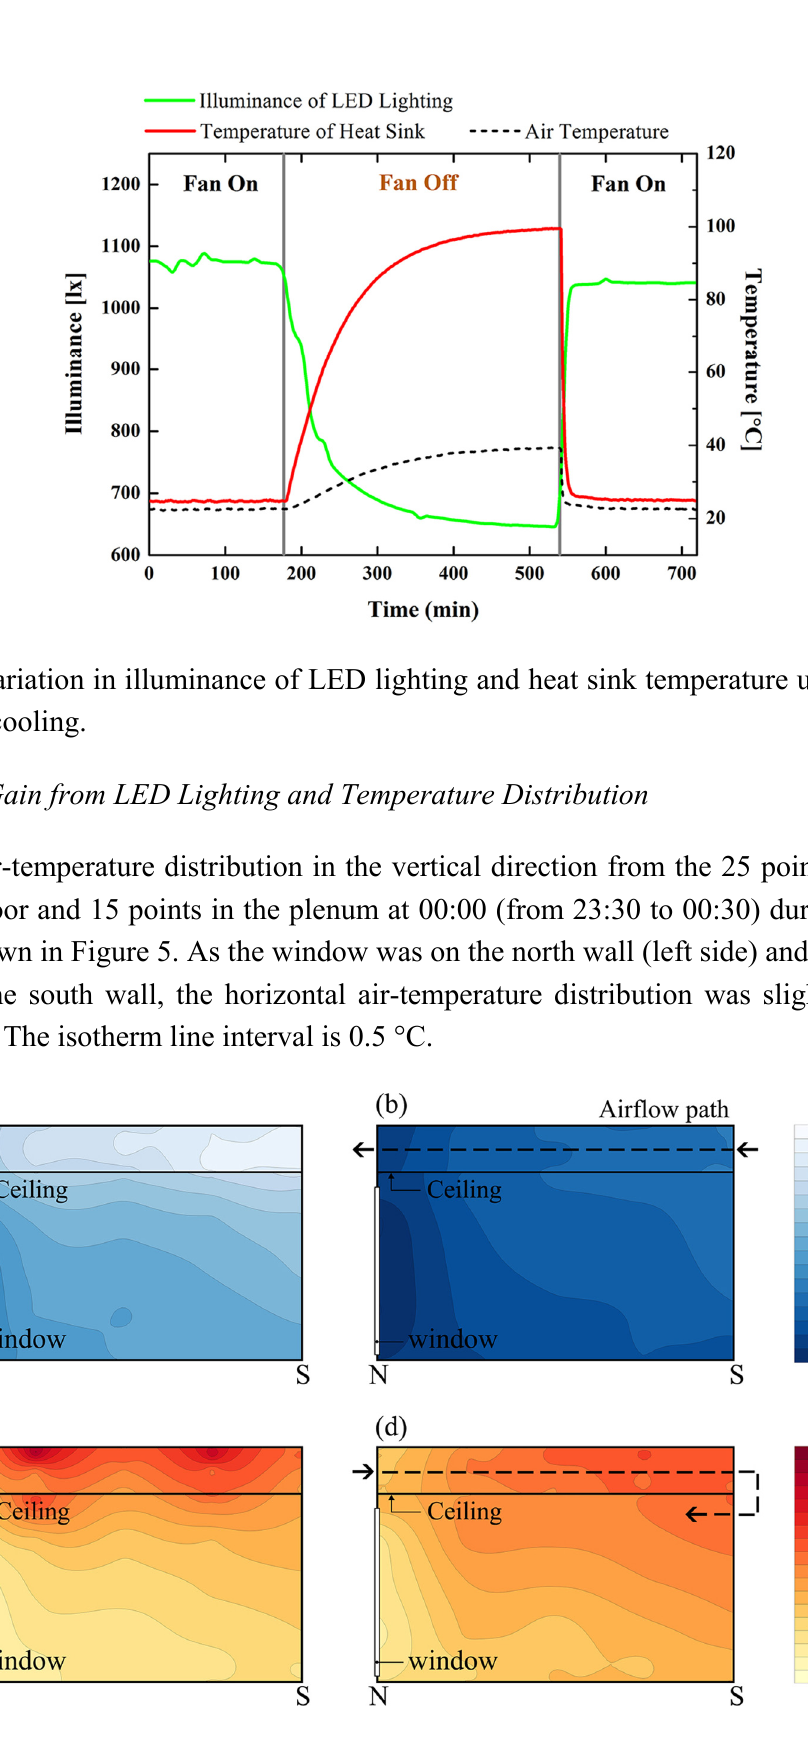
Figure 5. Vertical temperature distribution for the ATOS with seasonal strategy: ( a ) in summer without heat removal; ( b ) in summer with lighting heat removal; ( c ) in winter without heat reuse; ( d ) in winter with lighting heat